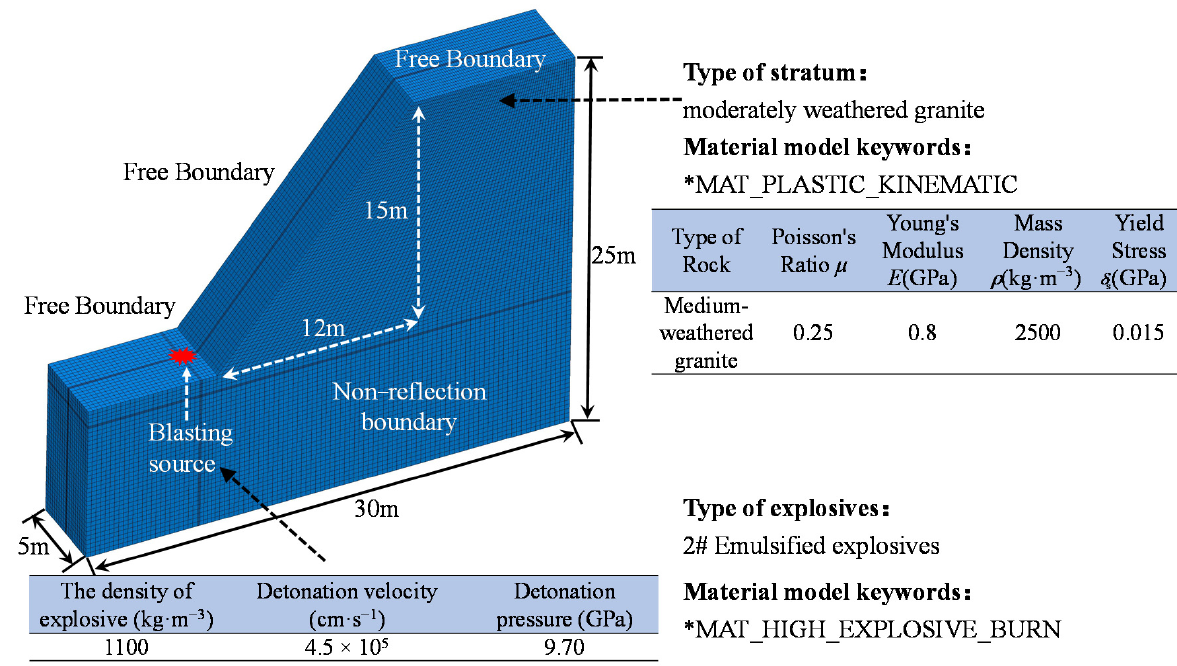
Figure 2. The 3D model of numerical simulation of work condition II.